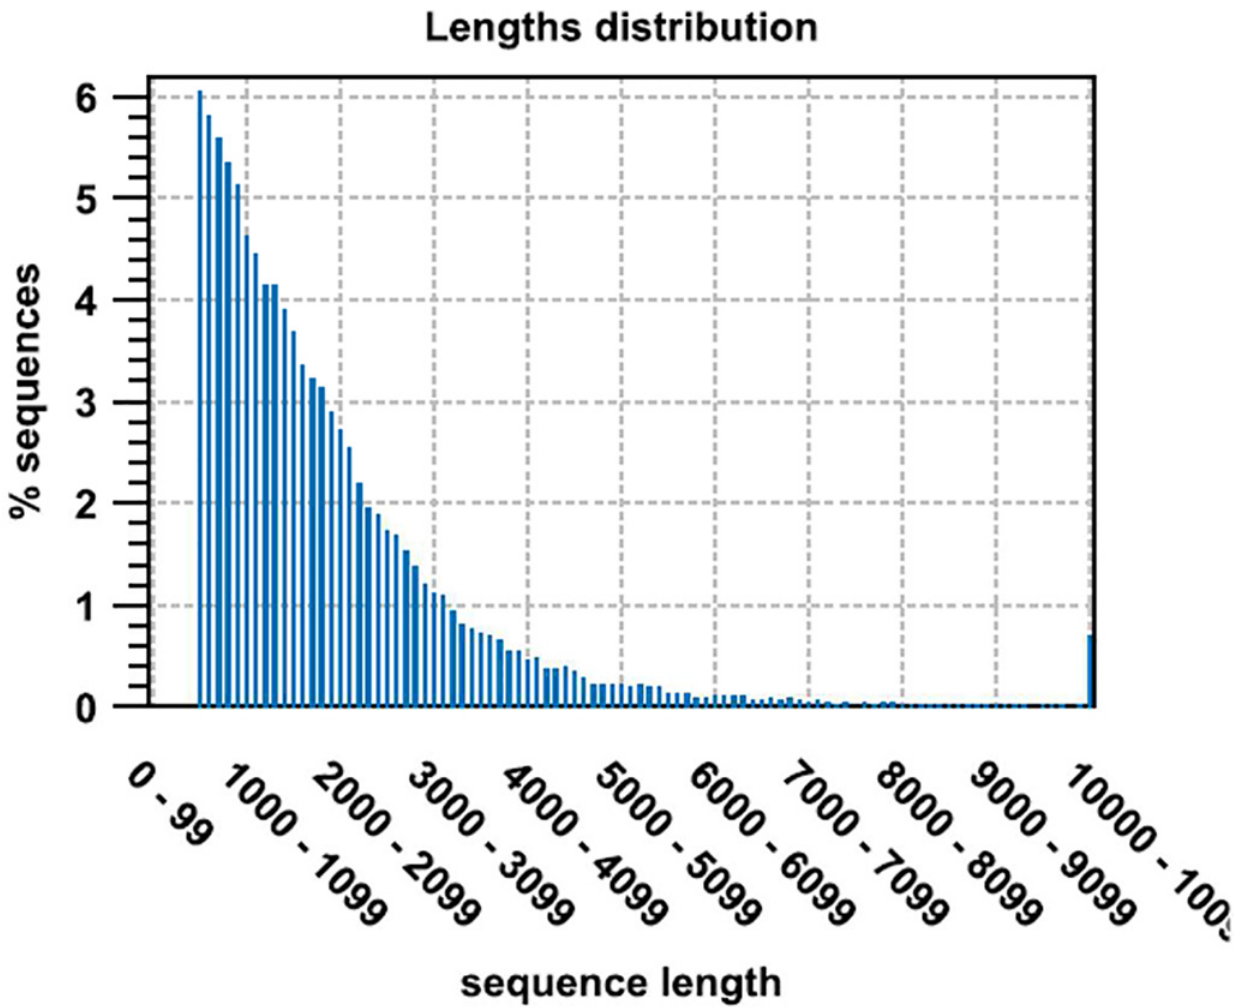
Fig 1. Distribution of contig ( (cid:1) 500 nt) length of a rainbow trout Illumina/Trinity transcriptome